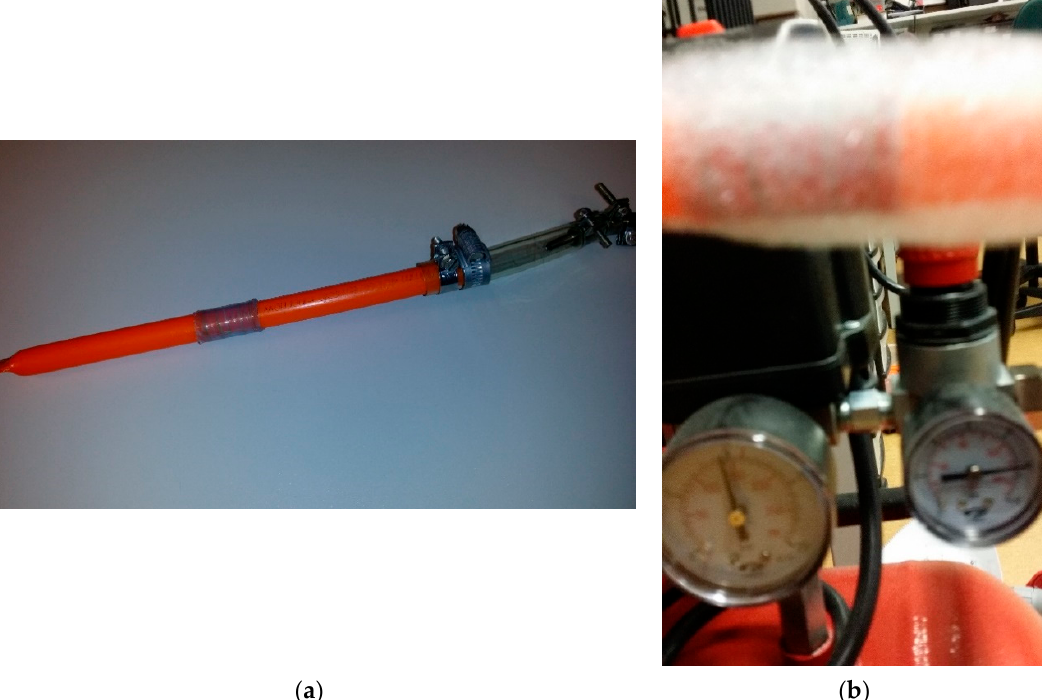
Figure 12. IOFEF joint welding sample: ( a ) Sample for air pressure test; ( b ) Air pressure test after welding.